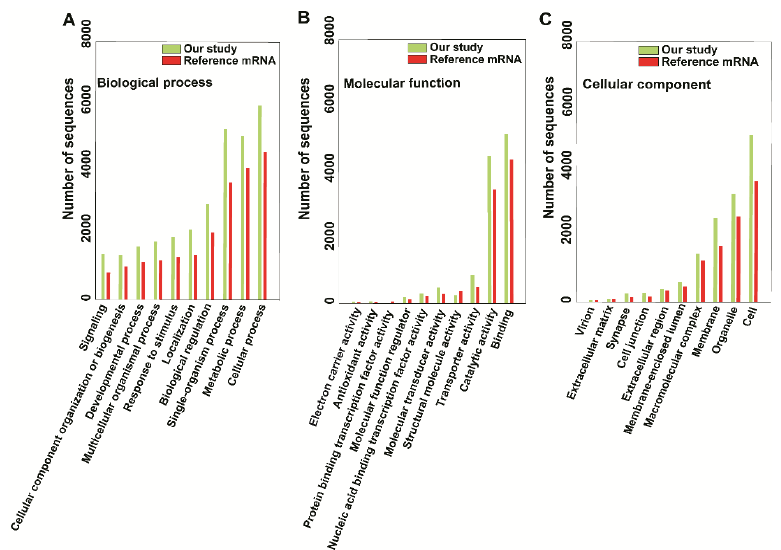
Figure 3. Comparison of top Gene Ontology (GO) mapping results. The results are summarized into three main categories: ( A ) biological process, ( B ) molecular function, and ( C ) cellular component. Dark green color indicates the number of sequences used in our study; dark red color indicates the number of sequences in the reference study